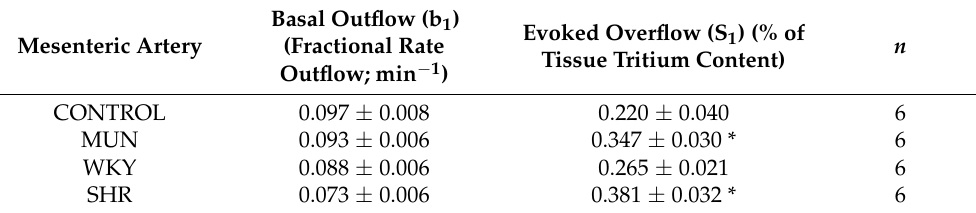
Table 3. Basal tritium outflow (b 1 ), electrically evoked tritium overflow (S 1 ) and S 2 /S 1 ratios from mesenteric arteries from CONTROL/MUN and WKY/SHR rats.